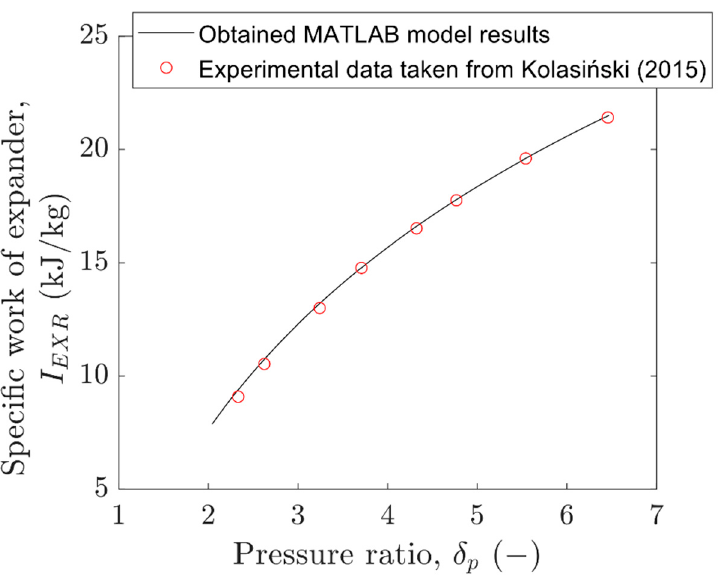
Figure 2. The obtained data from the MATLAB configuration validated using the experimental data from prior work.